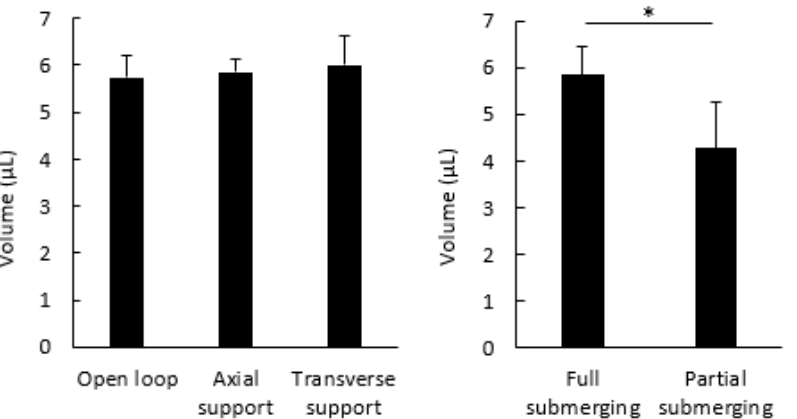
Figure 7. Volume capacity of the vitrification component with a loop length of 8 mm and width of 3.5 mm with different support configurations ( left ) and loading methods ( right ). Error bars represent the standard deviation. Asterisk indicates significant differences among the groups.